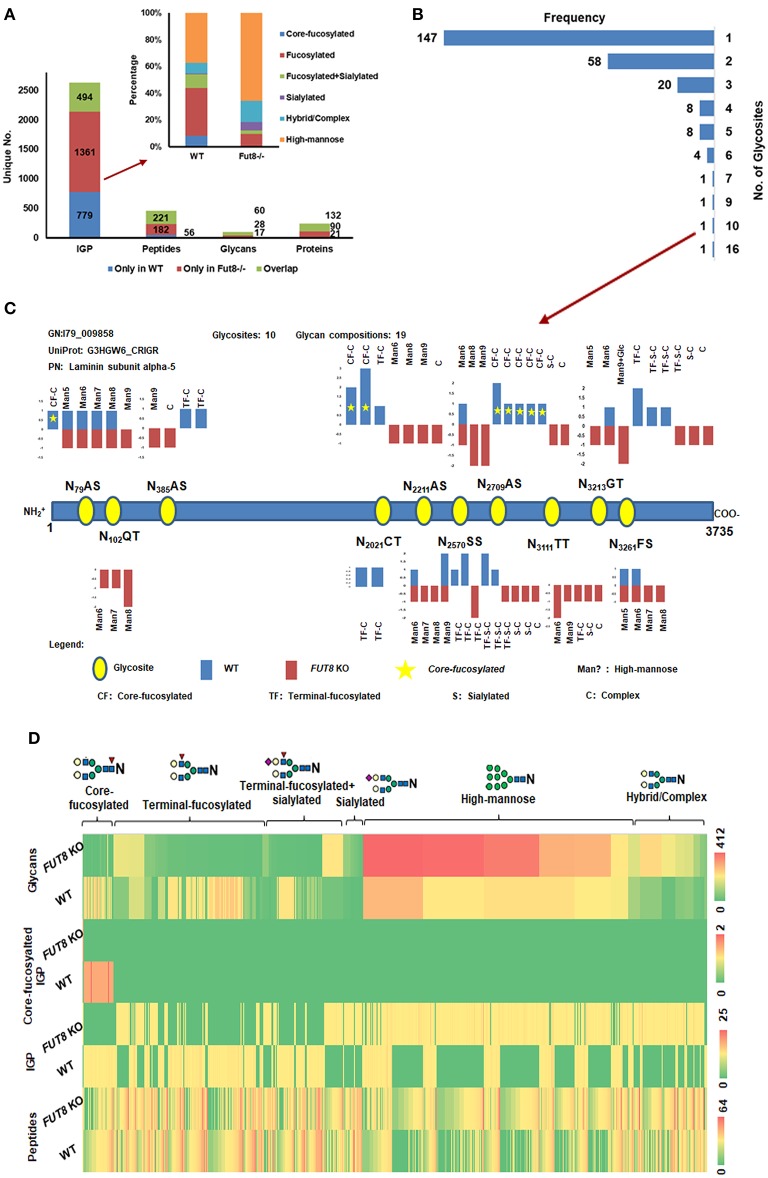
One-step enrichment of glycopeptides from WT and FUT8 KO CHO-K1 cells. (A) Distribution of IGPs, glycosites, glycans, and glycoproteins identified from WT and FUT8 KO CHO-K1 cells. (B) Glycosite frequency on the identified glycoproteins. (C) N-glycosylation of laminin subunit alpha-5 with 10 glycosites, including the structure type and relative abundance (peptide spectrum match) of glycans on each glycosite. (D) Heat map of glycosites, intact glycopeptides (IGPs), core-fucosyalted IGPs, and glycans of WT and FUT8 KO CHO-K1 cells.